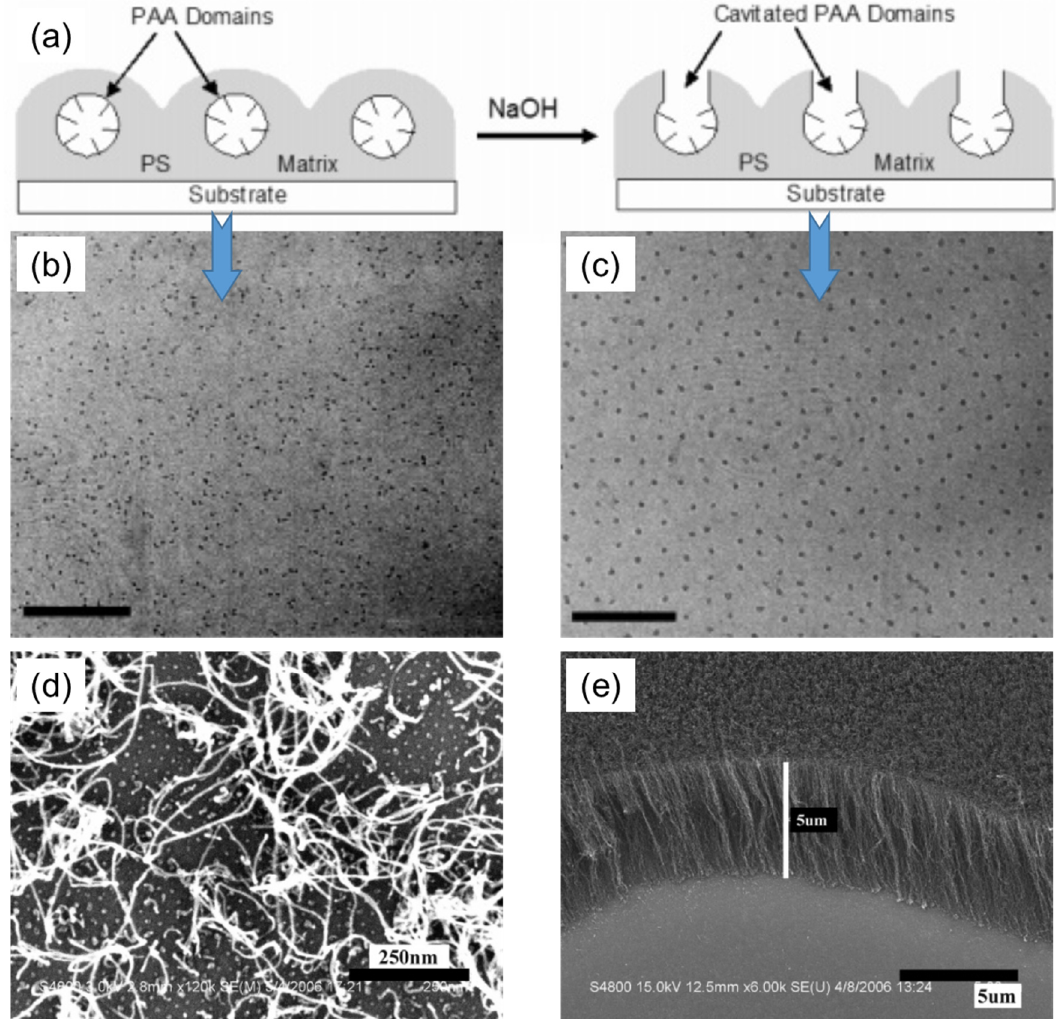
Figure 2. ( a ) Cavitation of PAA domain by submerging PS– b –PAA micellar arrays into NaOH aqueous solution. ( b , c ) TEM images of iron oxide nanoclusters synthesized using ( b ) non-cavitated template (scale bar = 200 nm), and ( c ) cavitated template (scale bar = 150 nm). Adapted from [21]. ( d , e ) SEM images of CNTs grown on Si substrate decorated with ( d ) low-density (1400/µm 2 ), and ( e ) high-density (3800/µm 2 ) particle arrays. Adapted from [22].